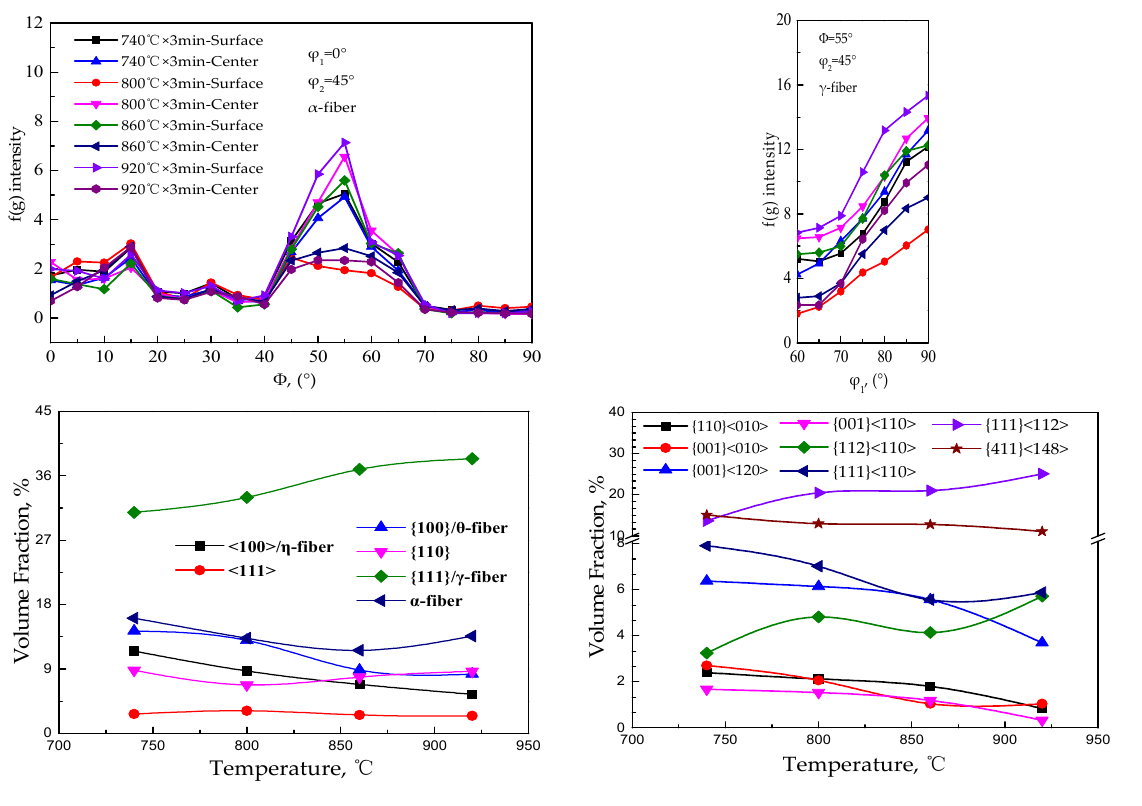
Figure 10. Orientation line distribution of α , γ fiber textures and distribution of texture content in Fe-0.65%Si non-oriented electrical steel annealed sheet during grain growth.